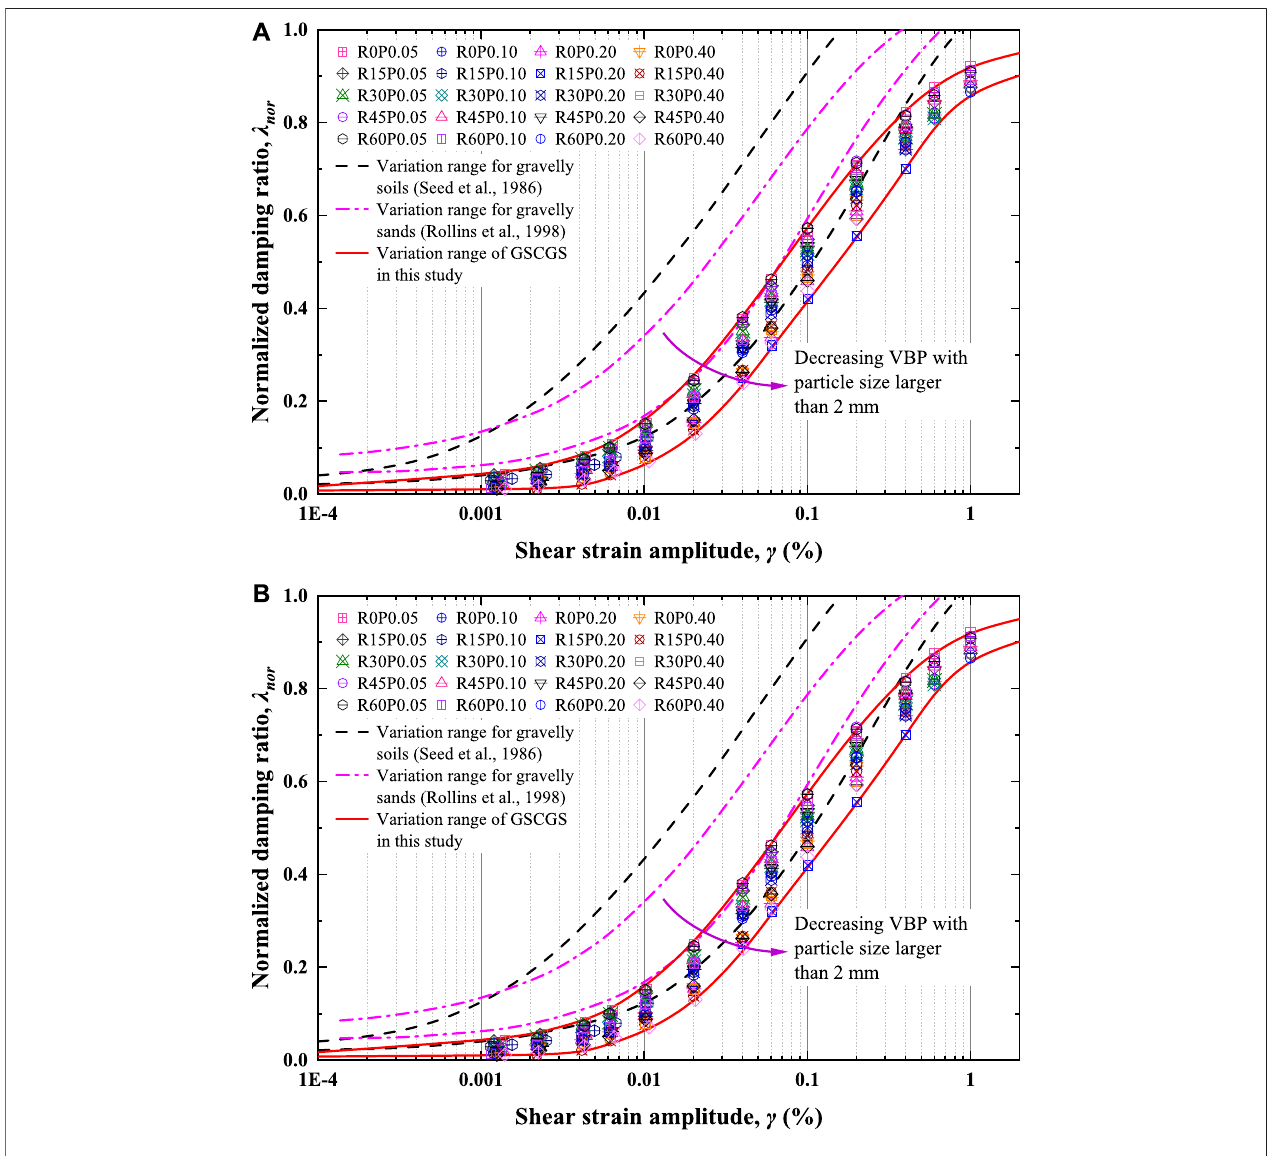
FIGURE 2 | G / G max and λ envelope curves of GSCGS with different VBPs under various CPs.